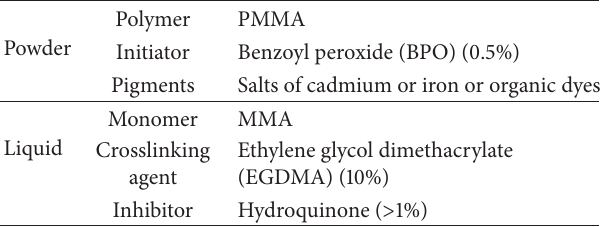
Figure 1: Chemical structure of PMMA.